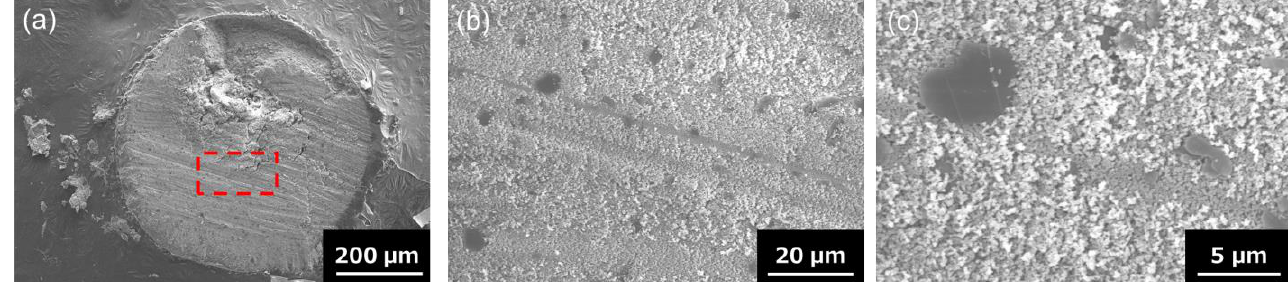
Figure 3. ( a ) Cross-sectional SEM images of a homogeneously hBN-incorporated Al 2 O 3 composite granule. ( b ) The higher magnification image of the region marked with the red-dotted line in ( a ). ( c ) Zoomed-in SEM image of an area in ( b ) indicating the presence of hBN sheets.